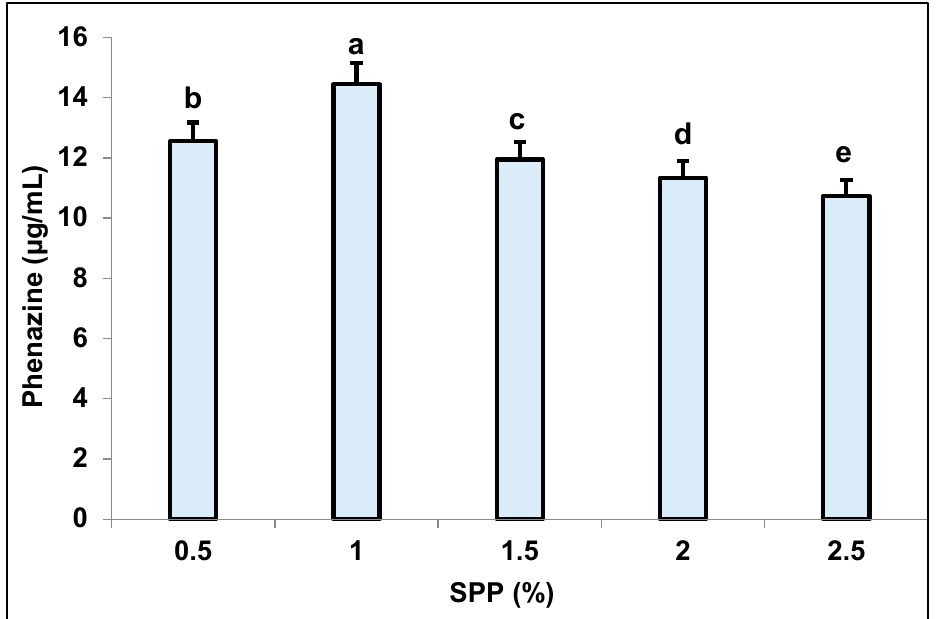
Figure 1. Effect of supplementary squid pen powder (SPP) concentration on phenazine biosynthesis. The analysis result showed that the different letters are significantly different. LSD (Least Significant Difference): 0.0778; CV (Coefficient of Variation): 0.232777.